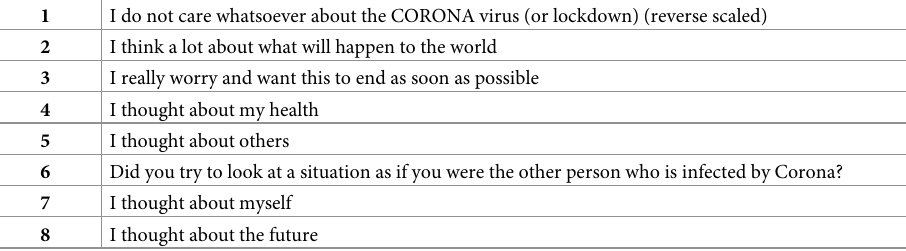
Table 1. Questions/statements included in COVID-19 Worry